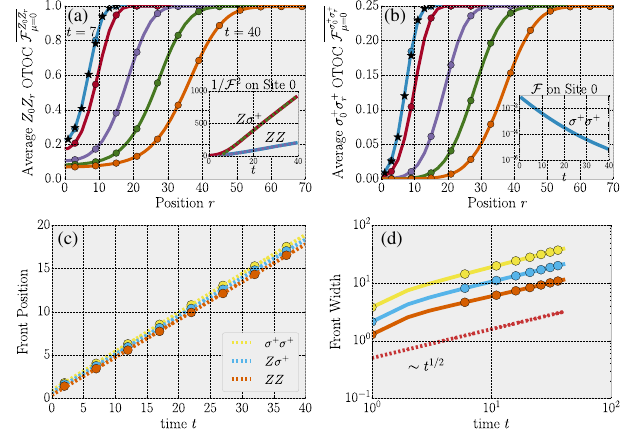
FIG. 4. The average OTOC F , defined in Eq. (9), at μ ¼ 0 , evaluated as a classical partition function. All OTOCs spread in a ballistically propagating front, which itself diffusively broadens in time, and saturate to zero behind the front. The shape of the ˆ Z ˆ Z front is shown for (a) the and (b) the ˆ σ þ ˆ σ þ OTOCs for times (from left to right) t ¼ 7 , 10, 20, 30, 40. The black stars represent data obtained by performing the unitary time evolution with TEBD and averaging over 100 realizations. The insets show the value of F for different operators at site 0 as a function of time. ˆ Z For OTOCs involving we find that 1 = F 2 grows linearly in time, ffiffi p t indicating a saturation F ∝ 1 = at long times, while the ˆ σ þ ˆ σ þ OTOC saturates exponentially fast. The two lower panels show the (c) position and (d) width of the front as a function of time. having similar front velocities v B ≈ 0 . 45 in units of the circuit light-cone velocity, while they all broaden diffusively. The position and the width are extracted from a curve that smoothly interpolates between the data points: the front position is defined by the point where the OTOC decays to half of its original value, while the width is computed as the inverse of the maximal derivative of this curve near the